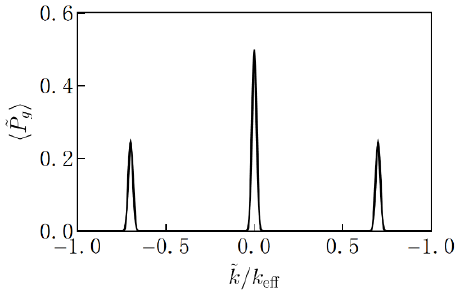
( ) = Figure 10. The signal for k t = 7 k eff with Ω 0 = 2 π × ( 100 MHz ) and ∆ 0 = 2 π × ( 500 MHz ) . This is 2π 100 MHz Ω = × and Figure 10. The signal for t eff 7 k k with 0 to be compared with graph (d) in Panel B of Figure 9, with the only difference being in the value of ( ) 2π 500 MHz Δ = × . This is to be compared with graph (d) in Panel B of Figure 9, with the k t . In this case, the signal is still very close to the ideal one that does not take into account the effect 0 of detuning, meaning that such parameters work fine for a momentum transfer of 7 k eff . This is the only difference being in the value of t k . In this case, the signal is still very close to the ideal one largest momentum transfer we have rigorously simulated so far. that does not take into account the effect of detuning, meaning that such parameters work fine for 7 k . This is the largest momentum transfer we have rigorously simulated a momentum transfer of eff earlier in Section 2, is determined primarily by the transition efficiency of each π − pulse ignore the dependence of the effective Rabi frequency on the momentum of the atoms. Therefore, we define the constant effective Rabi frequency as Ω eff ≡ Ω 2 /2 ∆ 0 . We 0